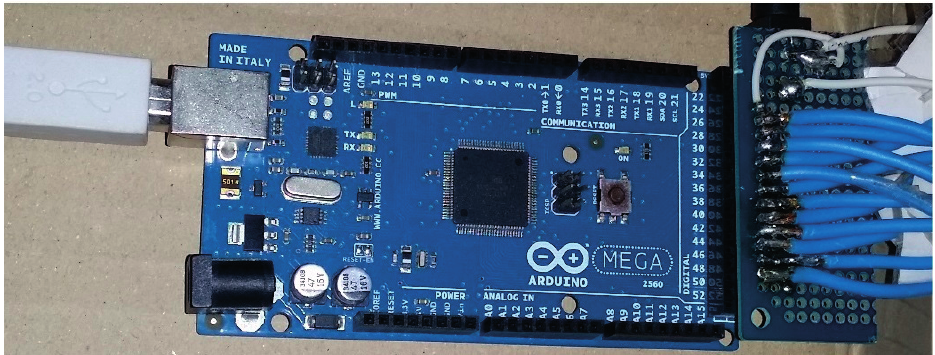
Figure 3. Schematic of experiment.